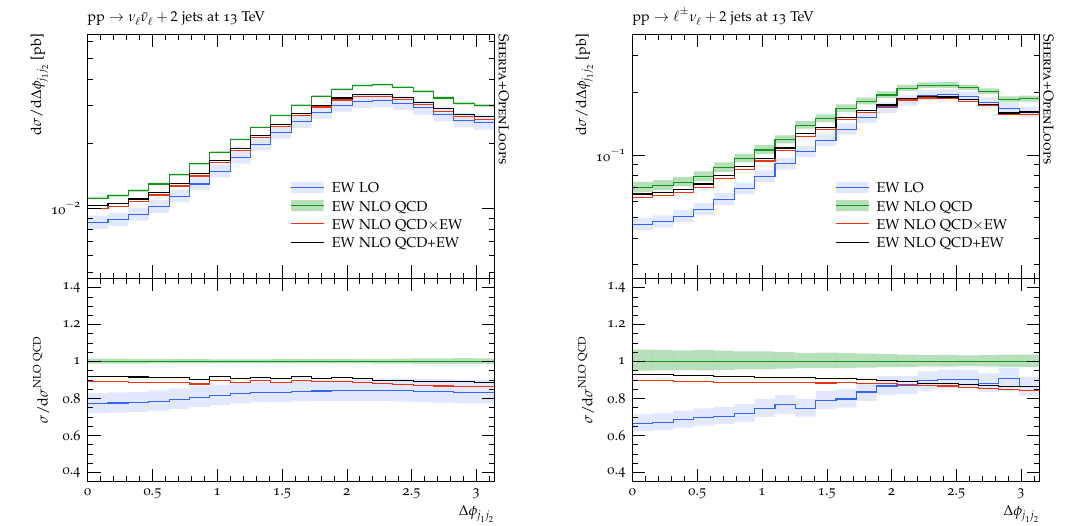
Figure 10. Distribution in the azimuthal separation of the two hardest jets, ∆ φ j pp → Z ( ν ‘ ¯ ν ‘ )+2 jets (left) and EW pp → W ± ( ‘ ± ν ‘ )+2 jets (right). Curves and bands as in figure 6.